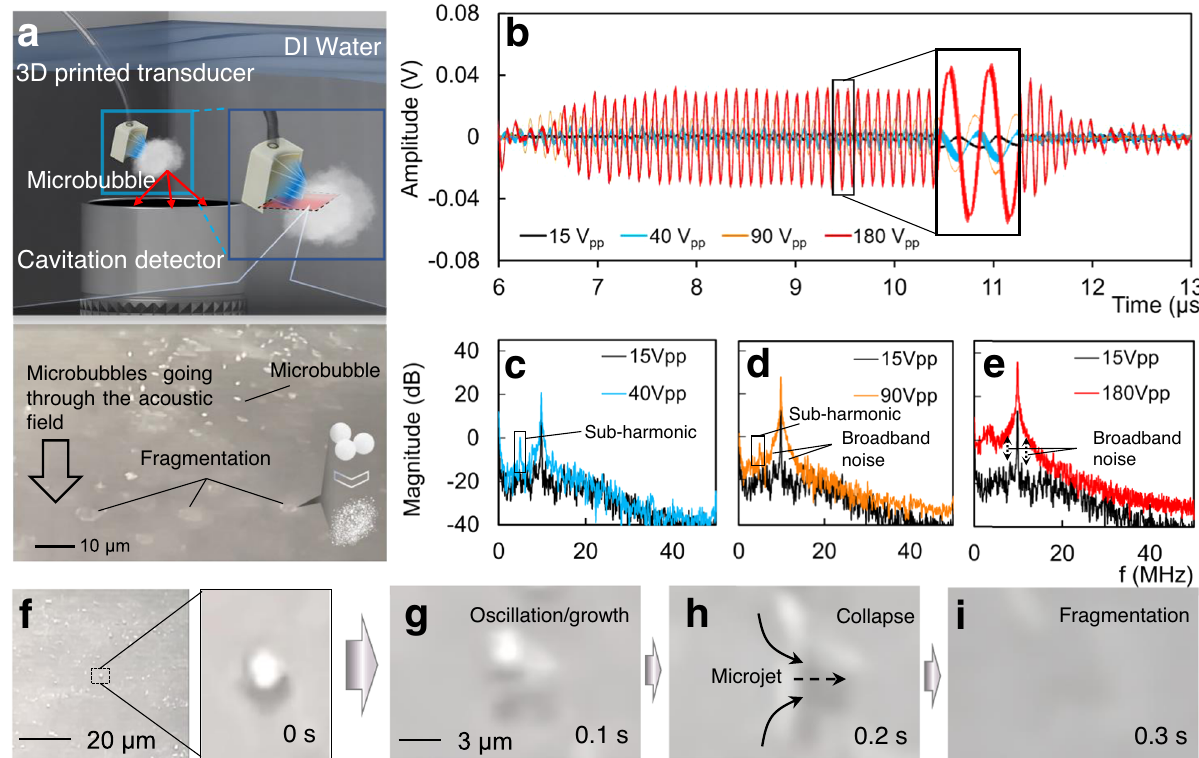
Fig. 4 | Microbubble-induced cavitation. a Schematic of the experiment on cap- turing the cavitation signal in a microbubble suspension and zoom-in view of microbubble fragmentation. b Captured signals (Input voltage: 15V pp , 40V pp , 90V pp and 180V pp ) in time domain. c – e Frequency spectrums of the received